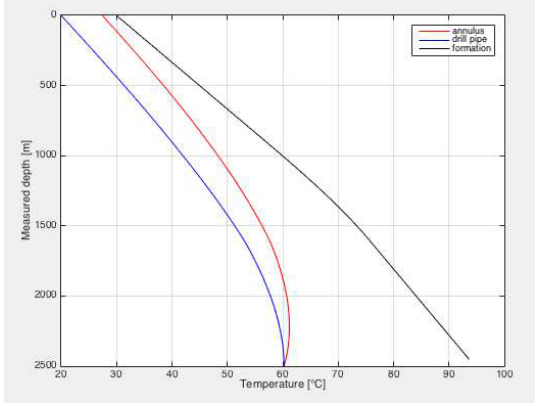
Figure 13: Temperature distribution- viscosity : 1 cP